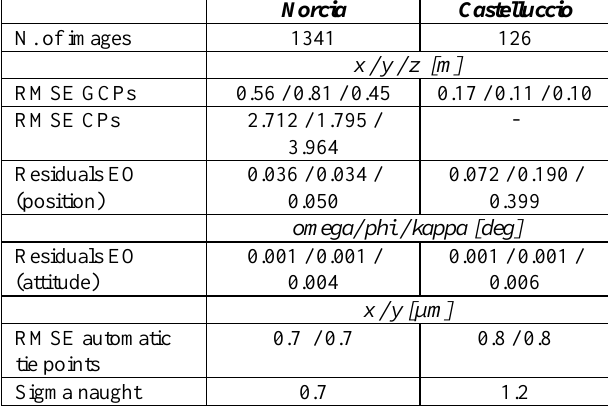
Table 1. AT results for the Norcia flight (the available CPs were of inferior quality).